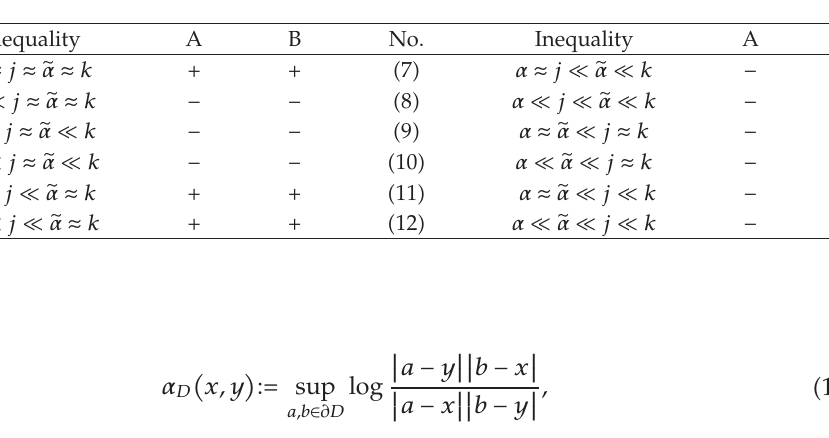
Table 1: Inequalities between the metrics α D , j D , (cid:2) α D , and k D . The subscripts are omitted for clarity with the understanding that every metric is defined in the same domain. The A-column refers to whether the inequality can occur in simply connected planar domains, the B-column refers to whether it can occur in proper subdomains of R n